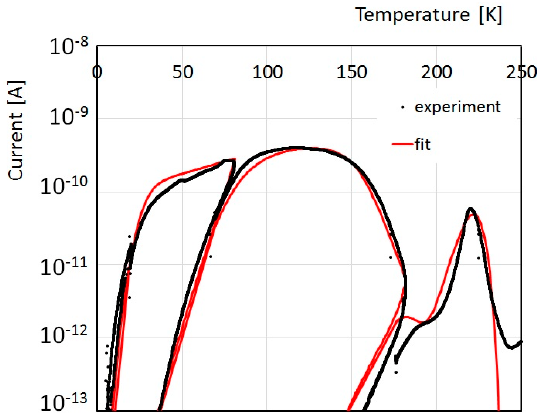
Figure 7. Experimental TSC measured in the 5–250 K range and best fit obtained considering the mixed conductivity model taking care of both hopping and free carriers conduction plus emission from a discrete energy level at 0.8 eV.